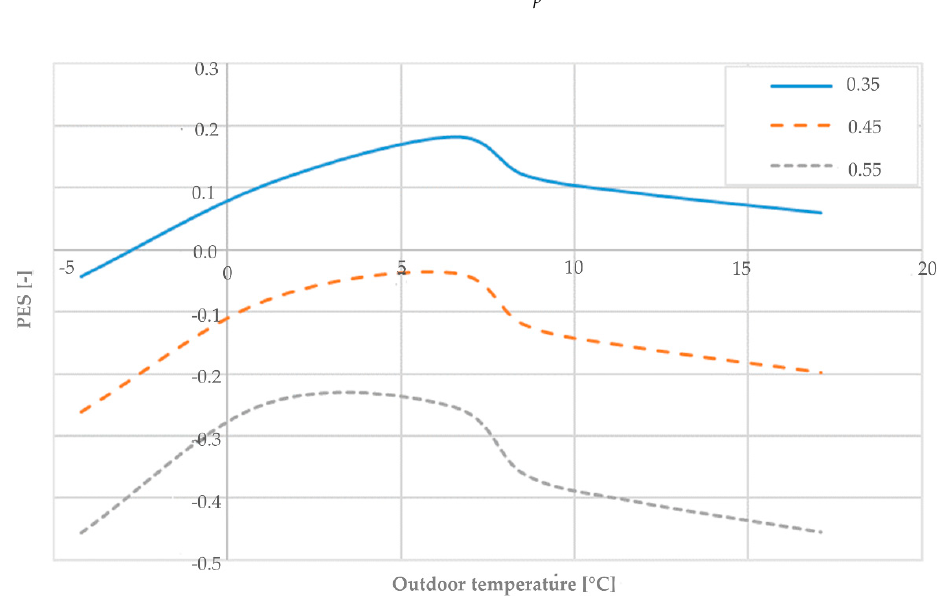
Figure 23. PES as a function of outdoor air temperature and power grid efficiency.